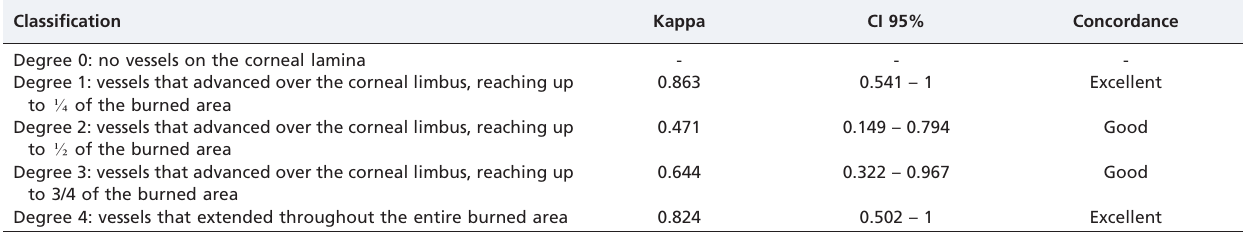
Table 3 - Concordance analysis among evaluations with respect to vessel extent.